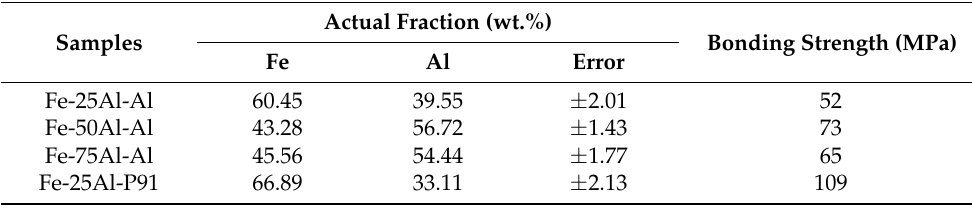
Table 3. A summary of the actual fraction and bonding strength of all